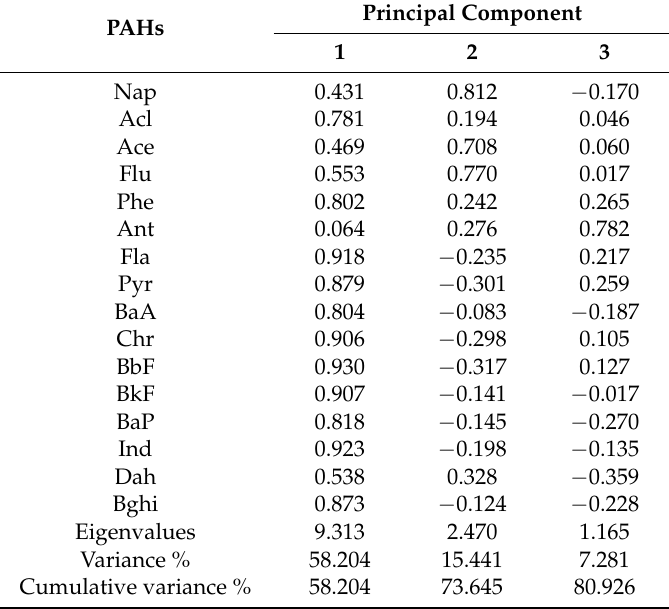
Table 3. The component matrix of PAHs in soil samples of the Momoge Wetland.